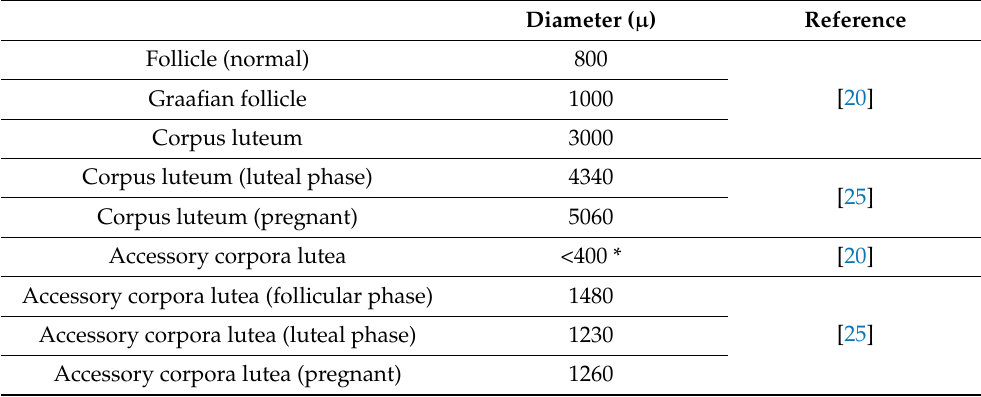
Table 3. Average morphometric data of the agouti’s ovarian